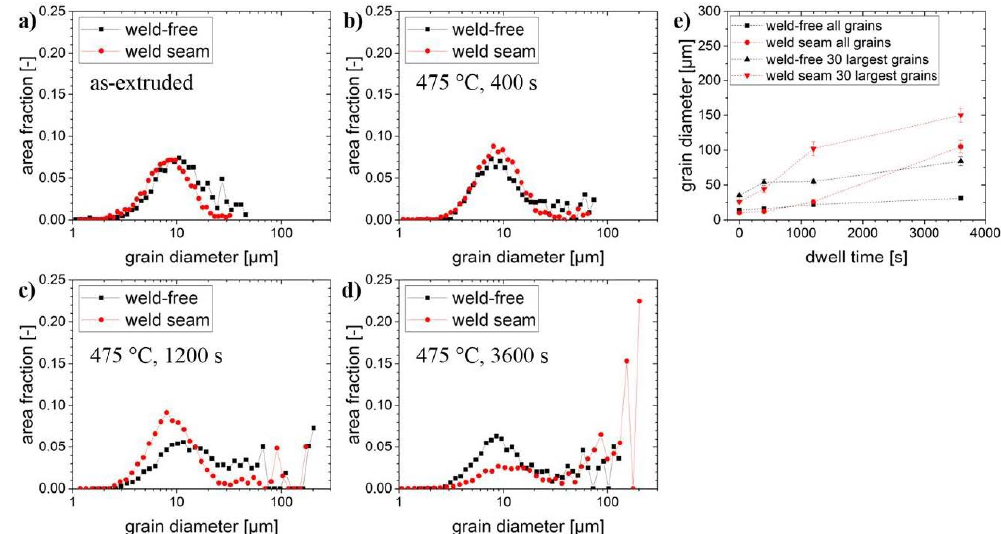
Figure 6. Evolution of the grain size distribution (computed from EBSD maps in Figures 2 and 4) in the as-extruded con- dition ( a ) and after heat treatment at 475 °C for ( b ) 400 s, ( c ) 1200 s, and ( d ) 3600 s. In addition, the average grain diameters of all recrystallized grains and of the 30 largest grains are plotted in ( e ) as a function of dwell time, ER = 8:1.